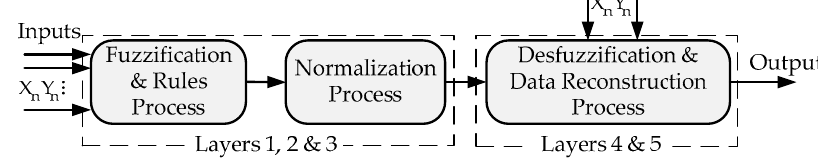
Figure 3. Brief illustration of ANFIS (adaptive neuro ‐ fuzzy inference system) structure.